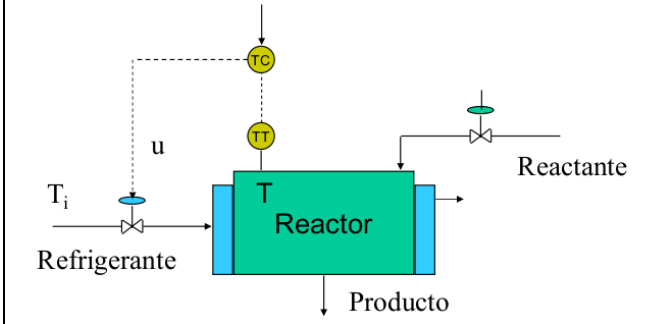
Figura 5: Lazo de control de temperatura T(t) de un Reactor químico tipo tanque continuamente agitado